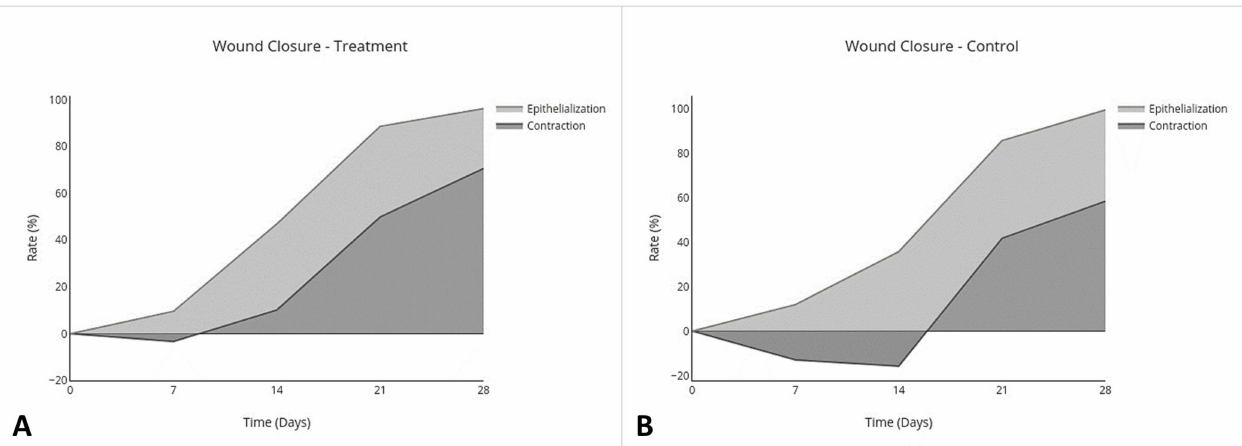
Figure 12. Total area (%) of contraction and epithelialization contributing to wound closure of treatment and control limb wounds. There was an overall increase in total contraction and epithelialization over all days in the treatment group ( A ). The lag phase was less pronounced in the treatment group, and wound closure was healed with approximately 75% contraction and 25% epithelialization ( A ), compared with 60% and 40% of contraction and epithelialization, respectively, in the control group ( B